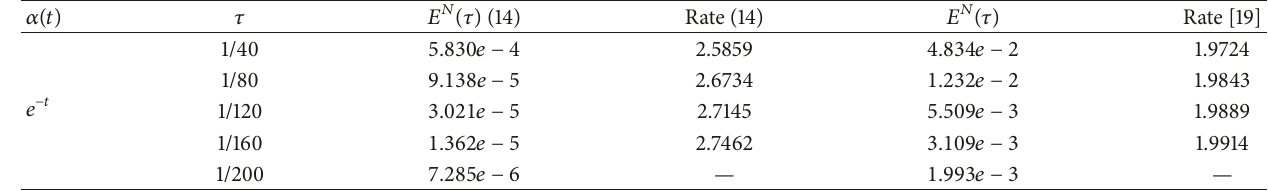
Table 2: Maximum errors and convergence rates for Example 1 at 𝑇 = 2 and 𝜎 = 1 − 𝛼 2 /2